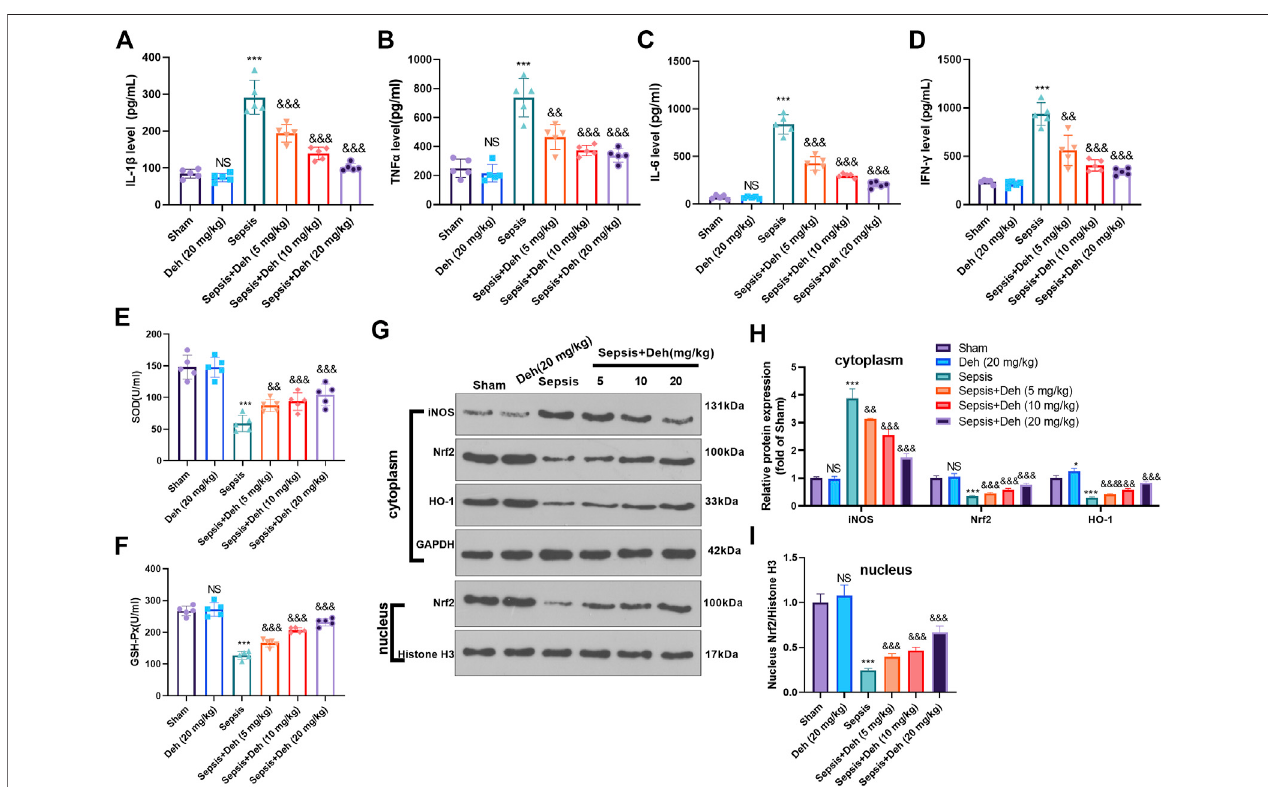
FIGURE 2 | Deh modulated sepsis-mediated in fl ammation and oxidative stress. (A – D) ELISA method was performed to detect IL-1 β (A) , TNF α (B) , IL-6 (C) , and IFN γ (D) levels in the plasma of mice in each group. (E, F) The SOD and GSH-PX detection kits were applied to detect SOD (E) and GSH-PX (F) levels in the plasma of mice in each group. (G, I) . The protein level of iNOS, Nrf2/HO-1 in the whole cell or nucleus of heart was detected by western blot. NS p > 0.05, *** p < 0.001 (vs. Sham group); && p < 0.01, &&& p < 0.001 (vs. Sepsis group). N (cid:1)